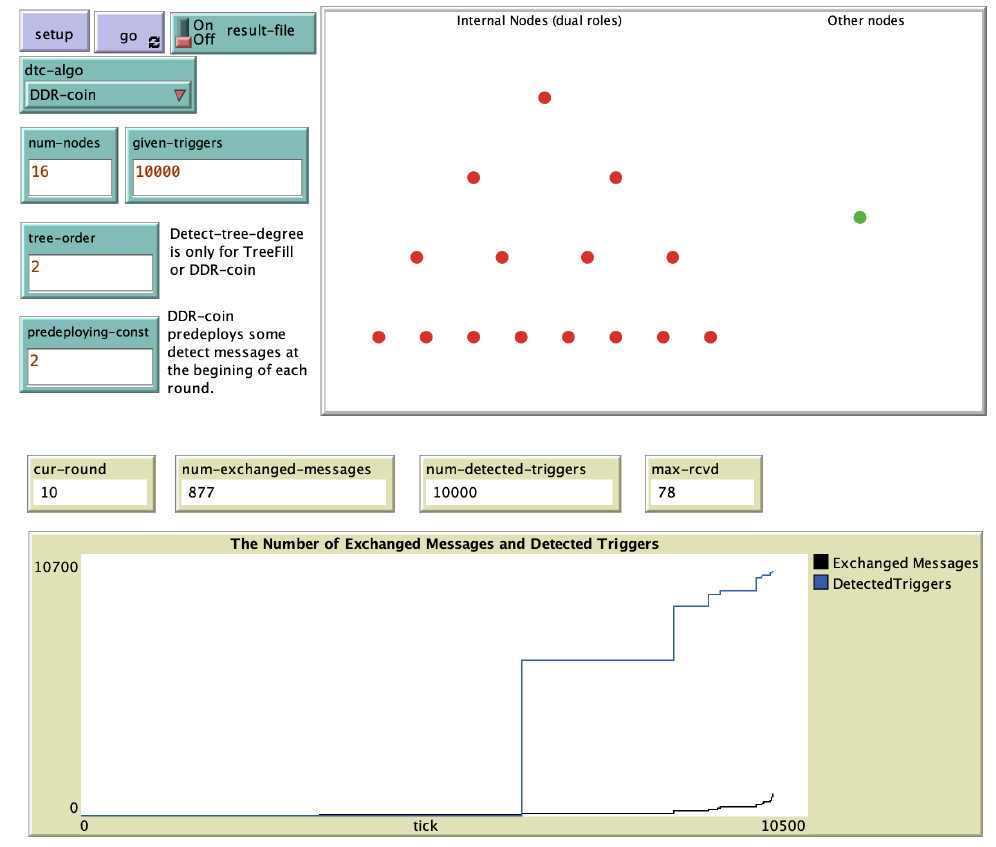
Figure 6. An example of DDR-coin simulation using NetLogo when n = 2 4 , κ = 2, and w =